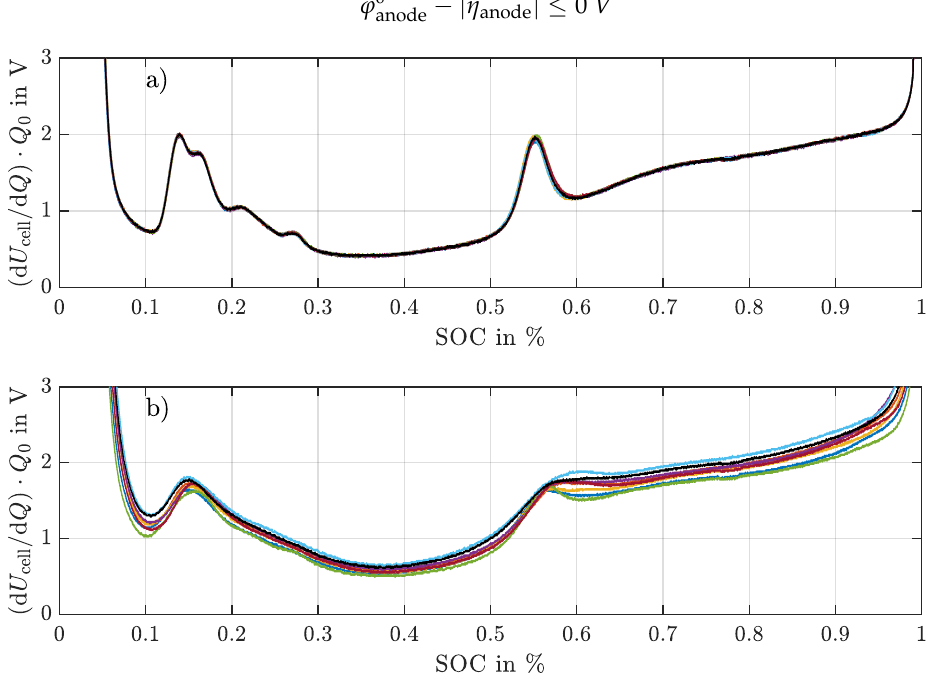
Figure 6. Differential voltage analysis of all 8 cells ( a ) before and ( b ) after 174